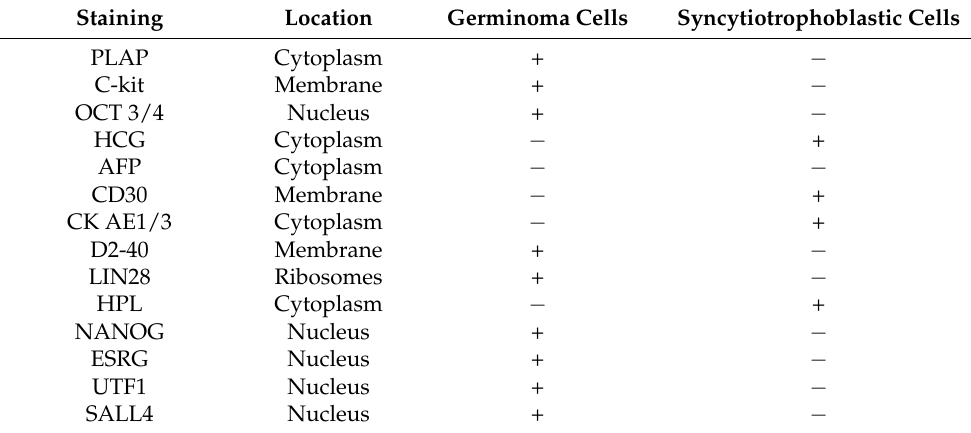
Table 2. Immunohistochemical staining in pure germinomas and germinomas with STGC. Staining